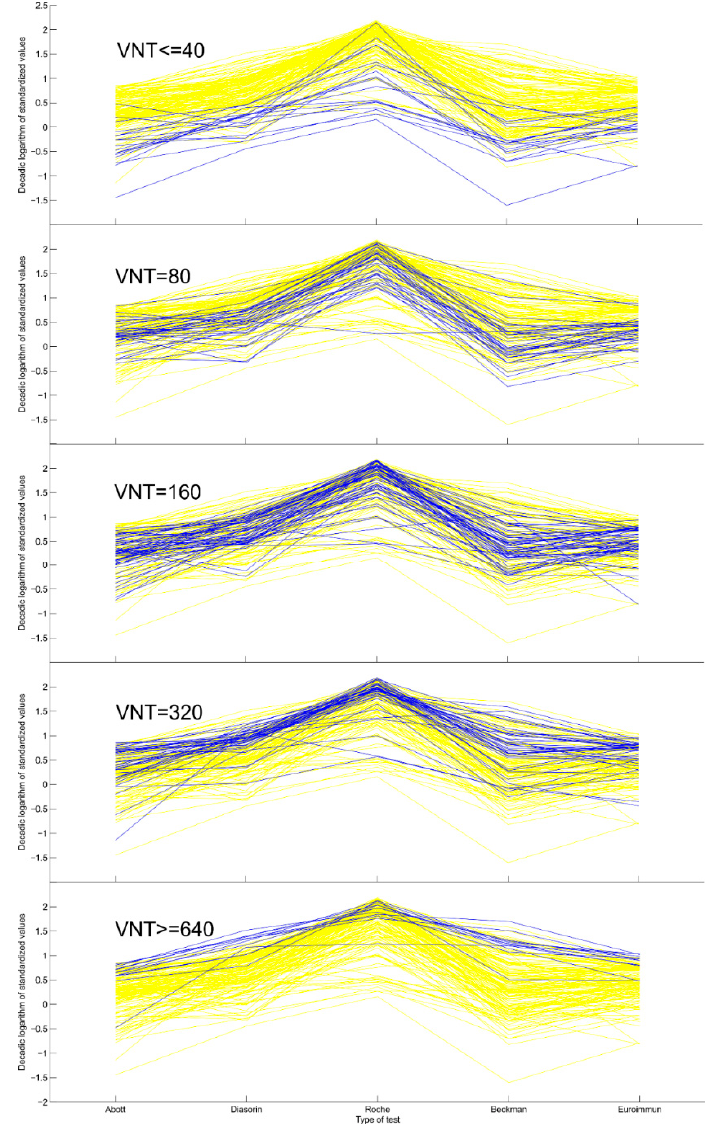
Figure 1. Visualization of the comparison of measured concentrations of SARS-CoV-2 antibodies by individual assays and overview of the data. Legends: The results of each test were standardized by taking the (decadic) logarithm of the ratio of the test result to the cut-off for negativity (see Table 4 and the text for more details). Each yellow line represents a single sample. In each panel, samples of particular VNT value are highlighted blue. We may observe the overall agreement of the five tests (Table 3) and the general correspondence of the VNT results with the five tests.